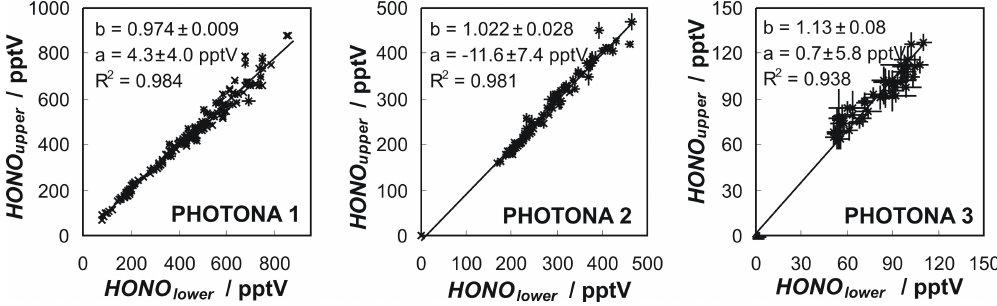
Figure 2. HONO mixing ratios measured at the same height during PHOTONA 1–3 (from left to right). The solid lines show linear weighted orthogonal regressions (Brauers and Finlayson-Pitts, 1997) between the two instruments. The slope (b) and intercept (a) are given with their (2 σ ) standard